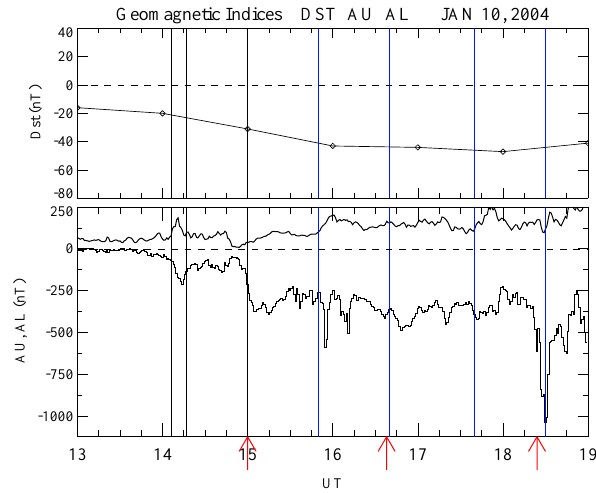
Fig. 3. Geomagnetic indices for the interval 13:00–19:00UT: Dst (upper), AU and AL (bottom). Vertical guidelines mark (i) south- ward turning responses at 14:00 and 15:00UT, (ii) substorm in- terval 1: 15:50–16:40UT, and (iii) substorm interval 2: 17:40– 18:30UT. Three DMSP F13 passes in the central polar cap are marked by red